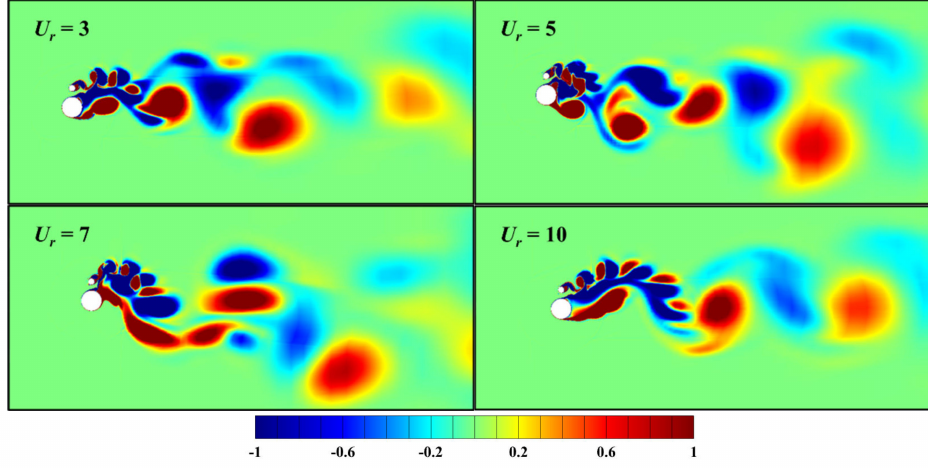
Figure 12. Instantaneous vorticity field for two coupled cylinders at α = 90 ◦ and d/D =